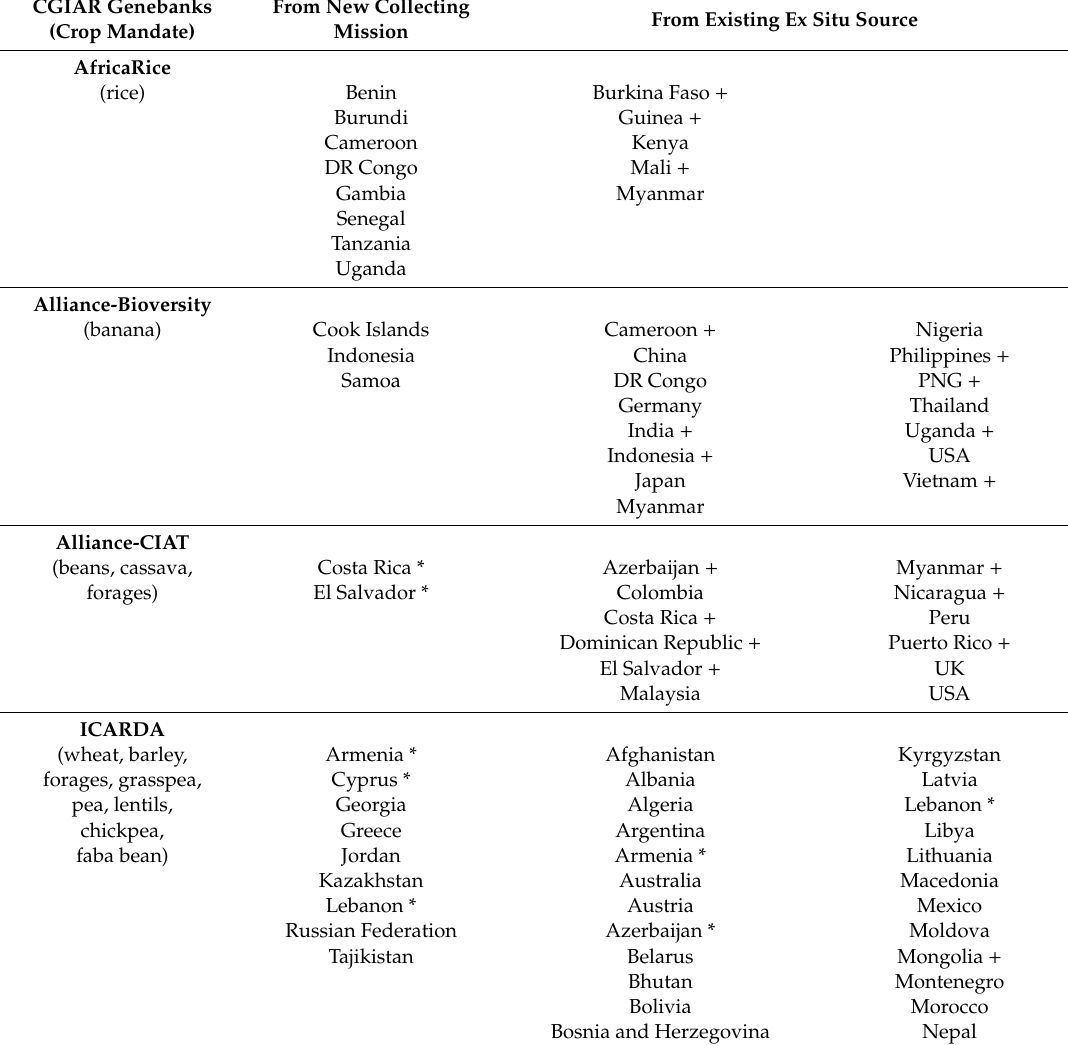
Table 1. Providers of materials acquired by CGIAR genebanks 2010–2019 (excluding CGIAR breeding programs)—Notes: associated with Regeneration project ( + ), CWR project (*). We separate the two genebanks hosted by the Alliance of Bioversity and